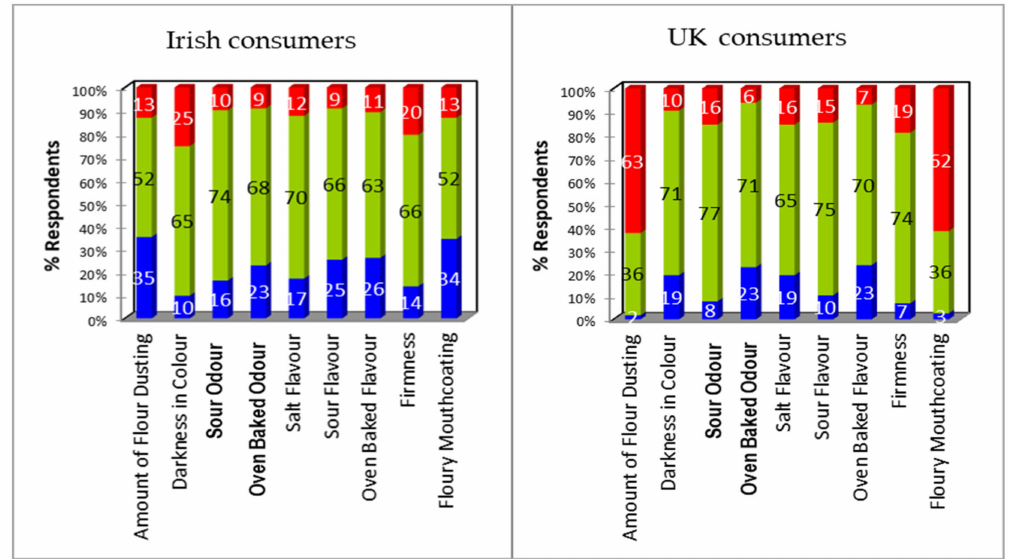
Figure 4. Deviation from ideal / just about right (JAR) for Blaa C from Irish ( left ) and UK ( right ) consumers. Data expressed as percent of responses from the collapsed JAR scale in which: Too little (blue) = rating of 1 + 2, Too much (red) = rating of 4 + 5, and Just right (green) = rating of